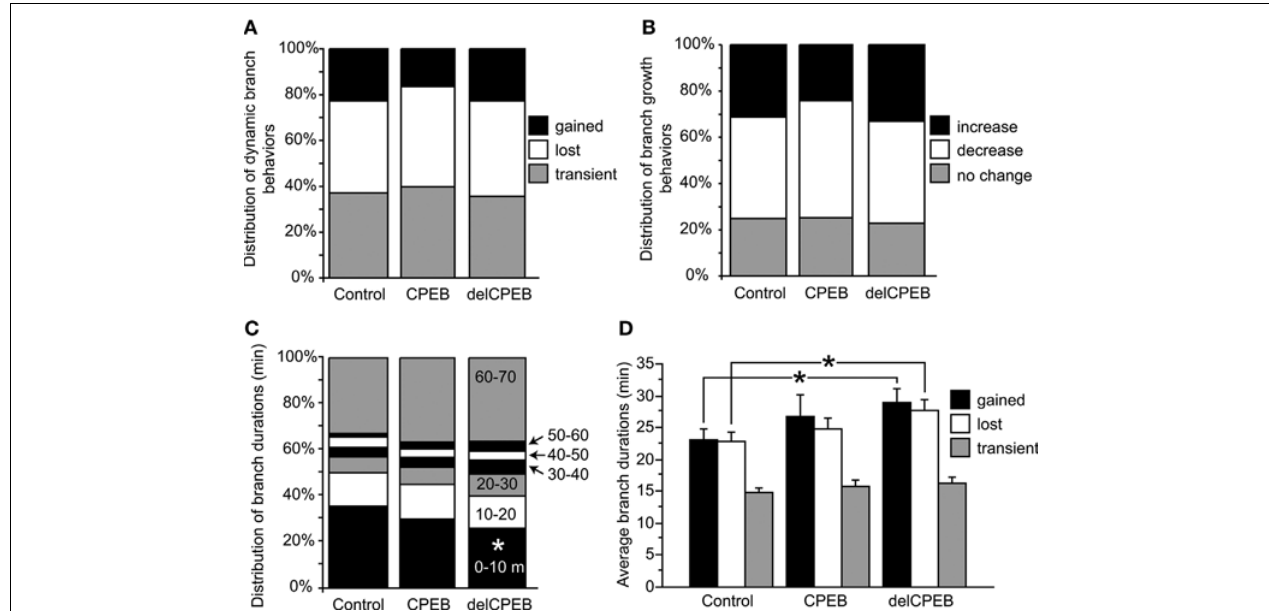
single time point of the experiment compared to control cells (Chi-square, p = 0.01). (D) Durations of the dynamic branches of the control YFP-, CPEB-, and delCPEB-expressing neurons. The gained and lost branches of delCPEB-expressing neurons were present for signifi cantly longer periods than control cells (unpaired t -test, p = 0.02 and 0.03, respectively). Values were measured from branches in their last appearance in the time-lapse. See Tables 1 and 2 for